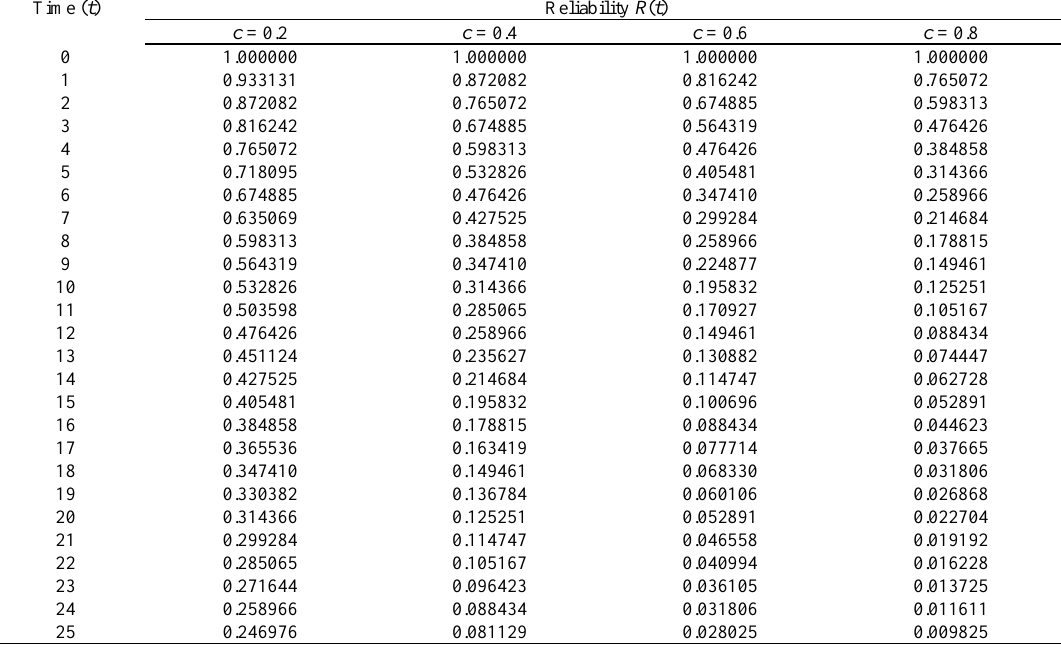
Table 9. Reliability of the system with copula- coverage.